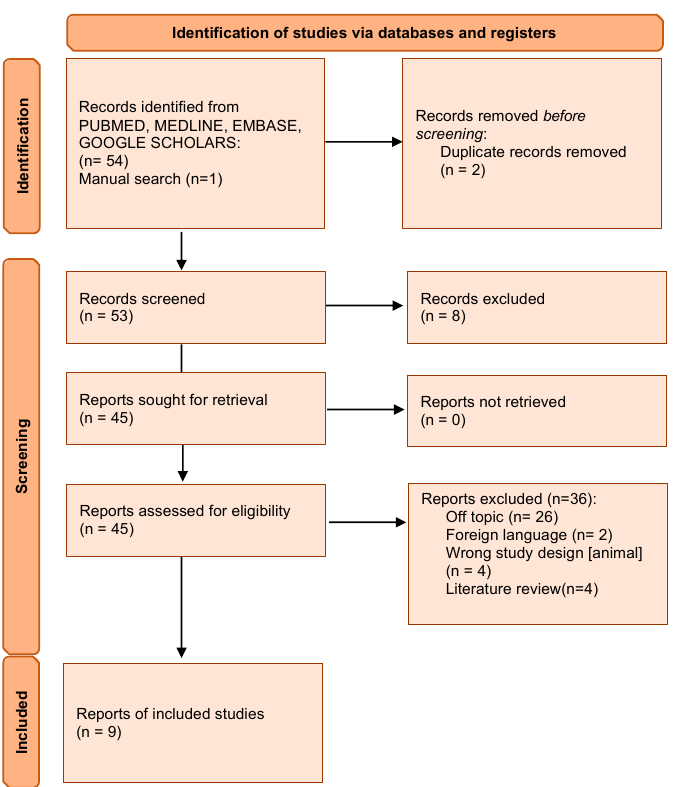
Figure 1. Preliminary Screening produced a total of 54 articles and one publication identified by manual screening.